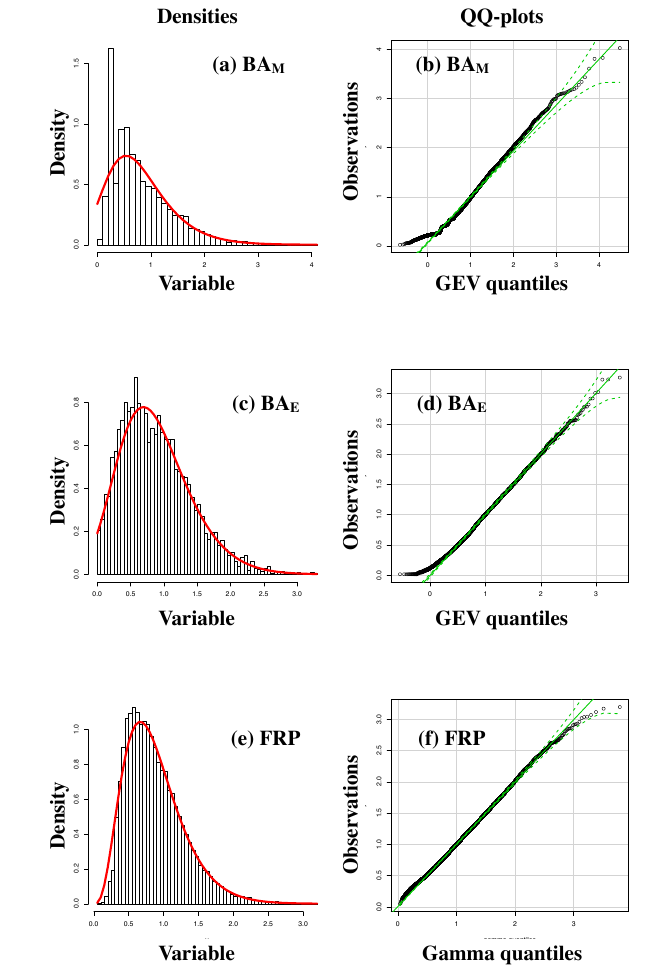
Figure 2. Normalized histograms, modelled densities (a, c, e) and QQ-plots (b, d, f) for the GEV and Gamma distributions for the BA and FRP data sets respectively. The fitting method used is the AD2R criterion minimization. On the densities panels the normal- ized histograms are in black and the modelled distribution in red. The dashed green lines on the QQ-plots are the 95% confidence